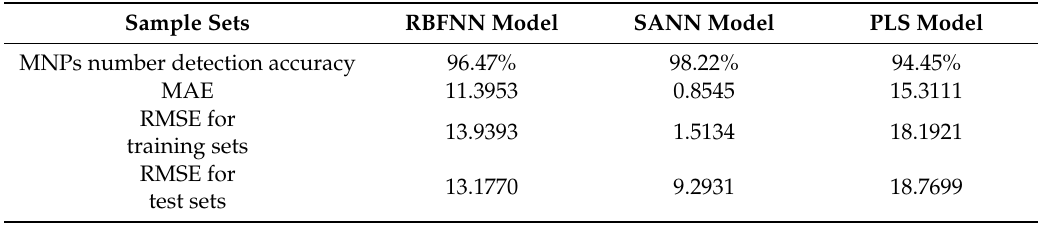
Table 10. Comparison of main evaluation indexes of di ff erent modeling